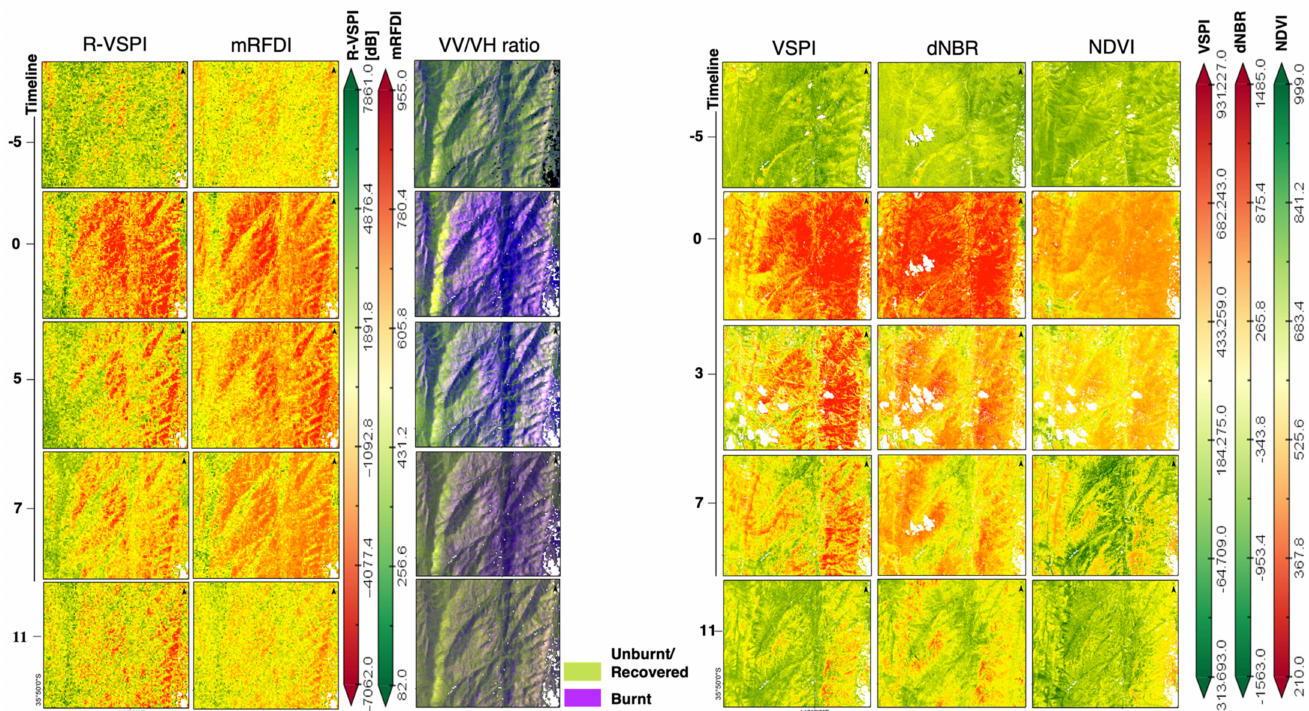
Figure 7. Multi-temporal comparison of SAR-based (R-VSPI, mRFDI, and VV/VH Ratio) and optical- based (VSPI, dNBR, and NDVI) vegetation indices for Orroral Valley wildfire that occurred in January–February 2020 in ACT. The colour maps for R-VSPI, mRFDI, VSPI, dNBR, and NDVI have been applied a linear stretch by a percent clip minimum and percent clip maximum value of 0.5. The VV/VH ratio maps are an RGB combination of the channels, red: VV, green: VH and blue: VV/VH, which signifies green as unburnt, and purple as burnt. The five scenes selected for optical include pre-fire scene: (i) 24 September 2019 ( − 5 months), closest date to the wildfire; (ii) 8 February 2020 (Timeline–0), and post-fire scenes; (iii) 15 July 2020 (5 months); and (iv) 18 September 2020 (7 months); and (v) 23 January 2021 (11 months). Similarly, the five scenes selected for optical indices include pre-fire scene (vi) 22 September 2019 ( − 5 months), closest date to the wildfire; (vii) 4 February 2020 (Timeline–0), and post-fire scenes; (viii) 15 May 2020 (3 months); (ix) 21 September 2020 (7